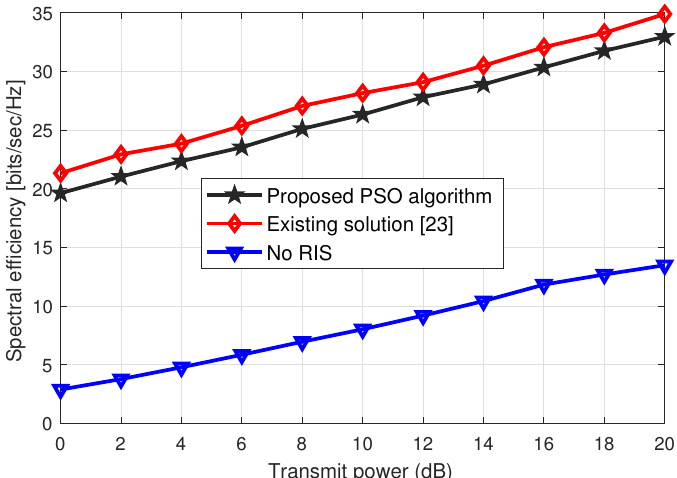
Figure 6. Spectral efficiency performance vs. transmit power (dBs) for N = 48.